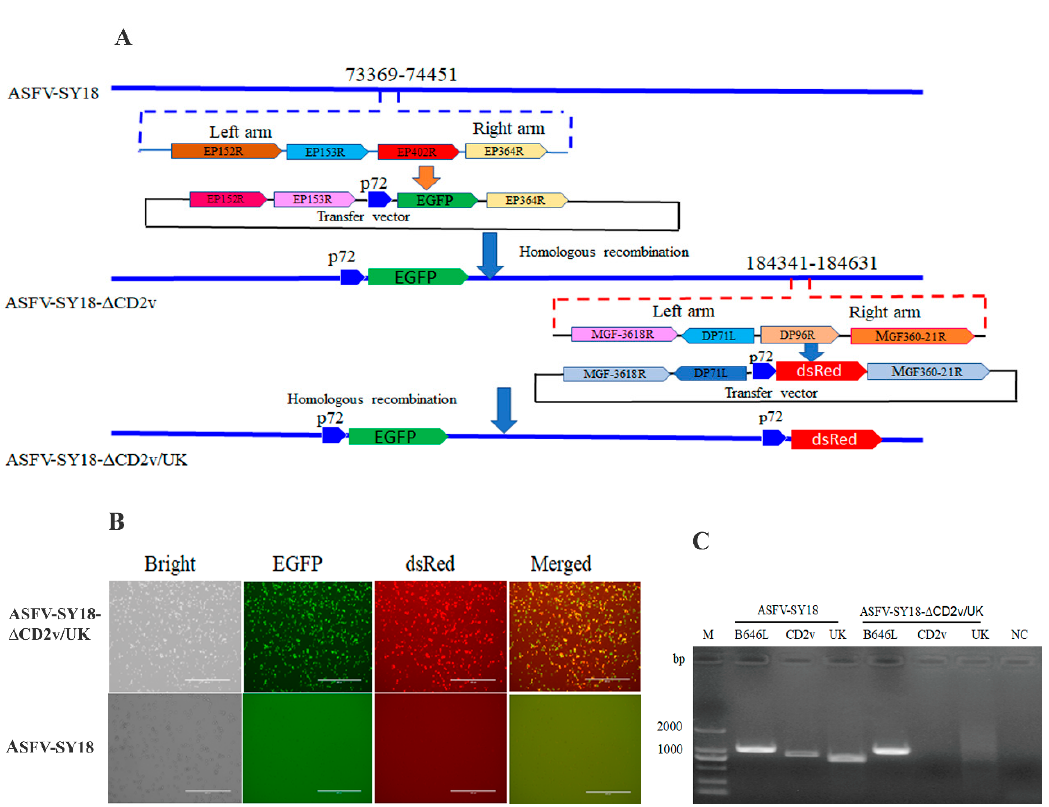
Figure 1. Deletion of the CD2v and UK genes from the ASFV-SY18 genome. ( A ) Schematic diagram representing the target site (s), the genes adjacent to the deletion sites and step-by-step generation of the double gene-deleted ASFV. The two recombinant transfer vectors designed to sequentially delete the CD2v gene at nt 73,369-74,451 and the UK gene at nt 184,341-184,631 of the ASFV-SY18 genome are shown. ( B ) ASFV-SY18- ∆ CD2v / UK amplification in alveolar macrophages (AM). ASFV-SY18- ∆ CD2v / UK- or ASFV-SY18-infected AM are shown in di ff erent fluorescence background (10 × ). ( C ) PCR analysis of ASFV-SY18- ∆ CD2v / UK stock. Viral DNA from ASFV-SY18- ∆ CD2v / UK or ASFV-SY18 infected AM were tested for the presence of CD2v or UK genes and the B646L ( p72 ) gene was used as a positive control to detect ASFV genome, NC is a negative control.